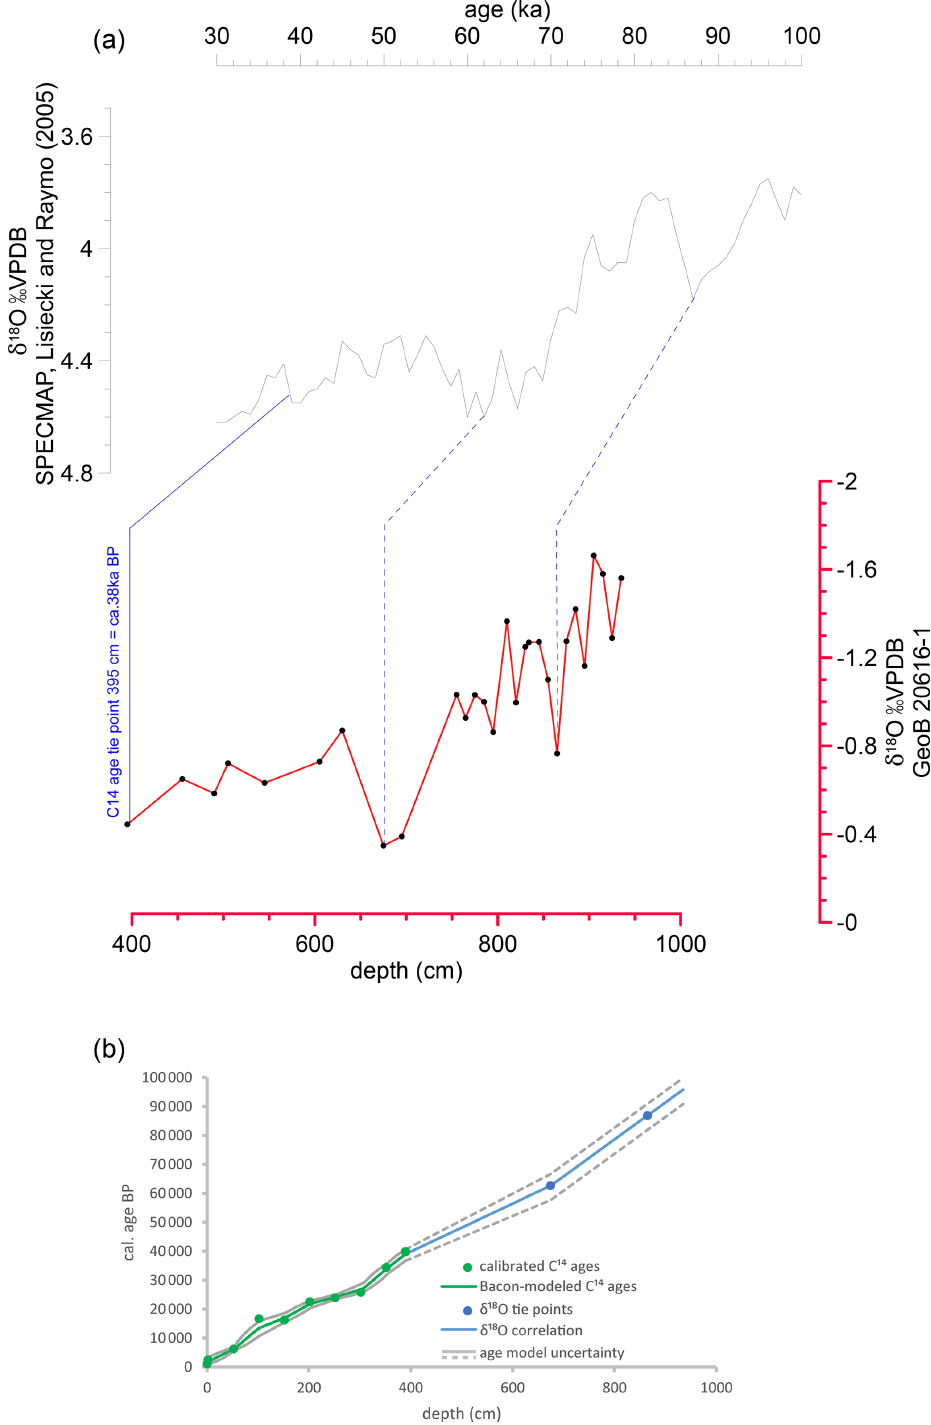
Figure 2. Reference curves and age–depth model of core GeoB20616-1. (a) LR04 benthic foraminifera δ 18 O stack (Lisiecki and Raymo, 2005) (black) compared to GeoB20616-1 (red) G. ruber foraminifera δ 18 O with indicated tie points. (b) Age–depth model based on Bacon v. 2.2 (Blaauw and Christen, 2011; green) and δ 18 O correlation (blue). Blue circles in panel (b) represent the positions of calibrated 14 C ages, whereas blue circles indicate δ 18 O tie points. Gray lines indicate